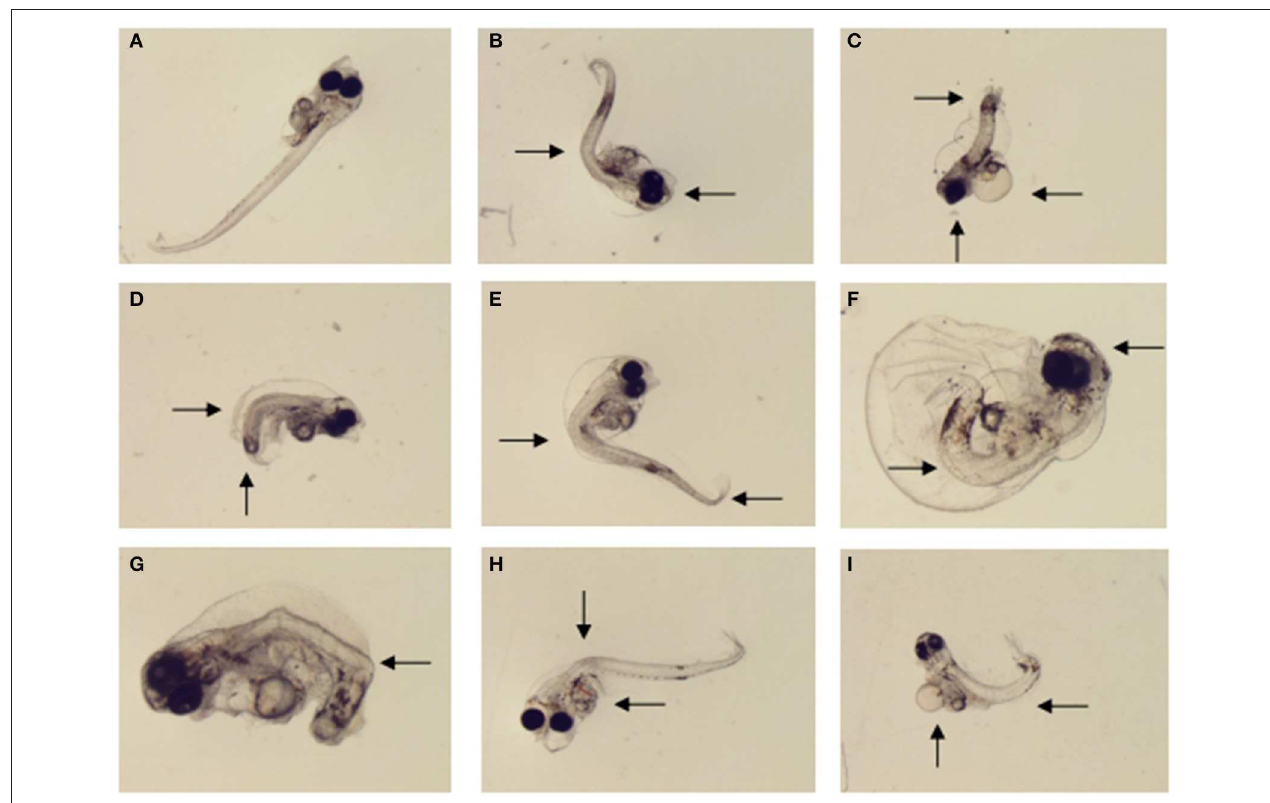
FIGURE 5 | Morphological malformations of the large yellow croaker larvae by MeHg exposure in the sub-chronic toxicity test: (A) normally developed larvae (control), (B) eye fusion and spinal deformity (20 µ g L − 1 ), (C) head dysplasia, fin rot and tail hypoplasia (40 µ g L − 1 ), (D) spinal deformity and tail hypoplasia (1 µ g L − 1 ), (E) spinal deformity and tail bending (5 µ g L − 1 ) (F) eye fusion, fin rot and spinal deformity (40 µ g L − 1 ), (G) body color abnormalities and tail hypoplasia (10 µ g L − 1 ), (H) visceral hemorrhage and spinal deformity (10 µ g L − 1 ), (I) periventricular edema and spinal deformity (10 µ g L − 1